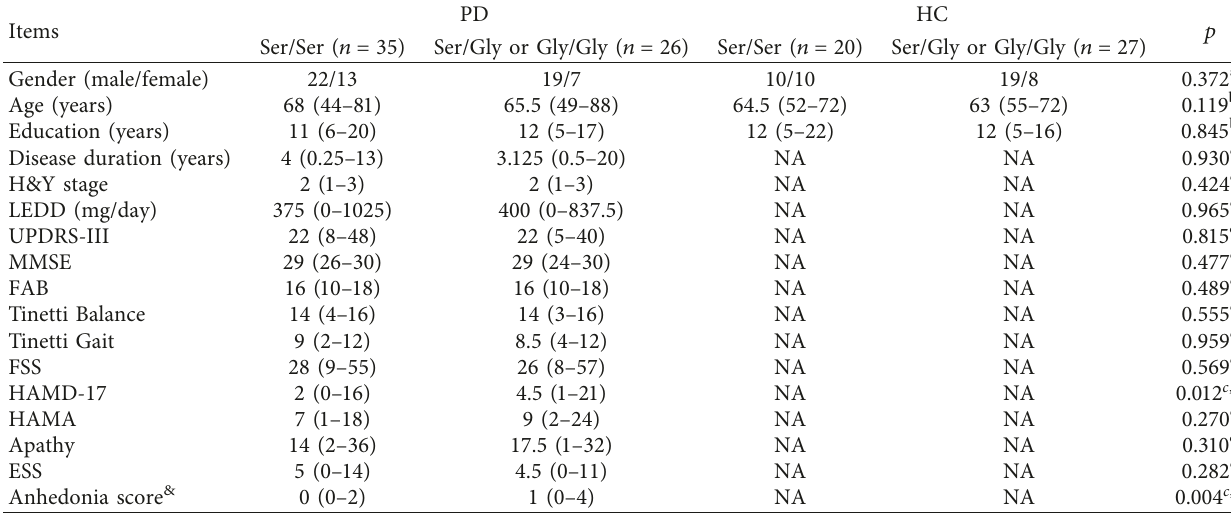
Table 2: Demographic data of participants.